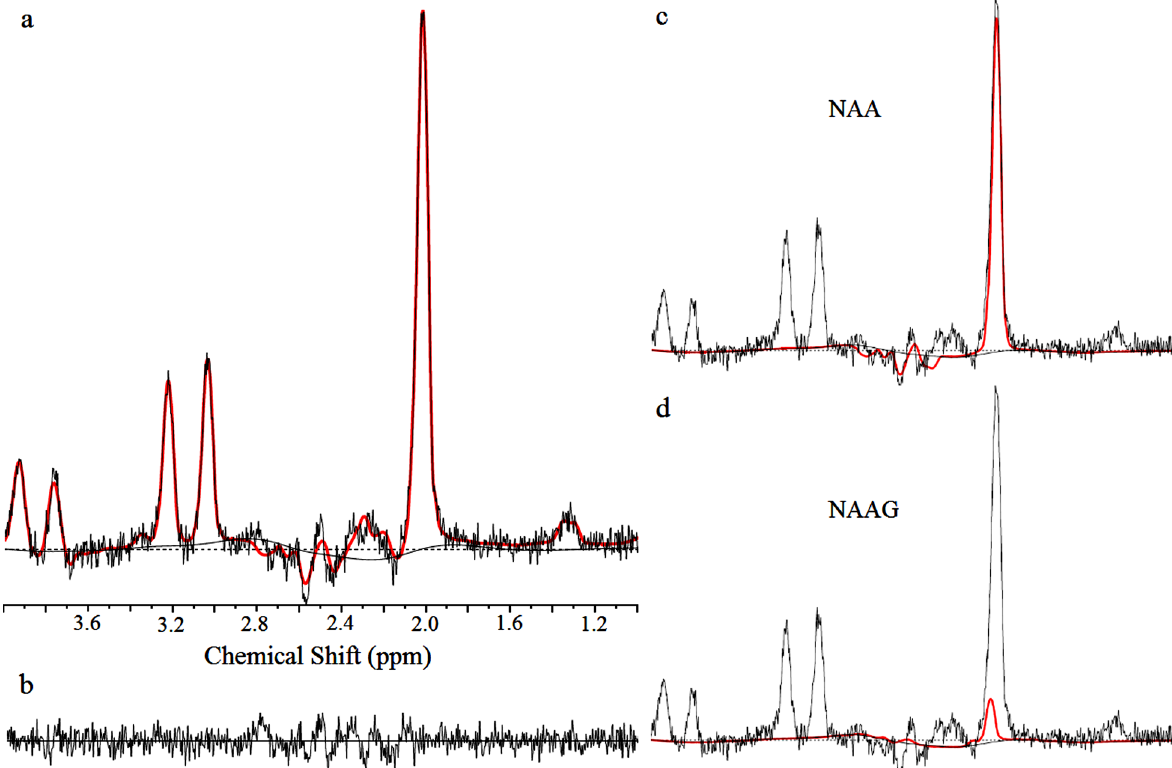
Figure 1. Example of averaged-over-subjects spectrum. a , Measured spectrum (black line) and LCModel fit (red line). b , Correspond- ing residue. c , Individual N-acetyl-aspartate (NAA) fit for the spectrum in a . d , Individual N-acetyl-aspartyl-glutamate (NAAG) fit for the spectrum in a